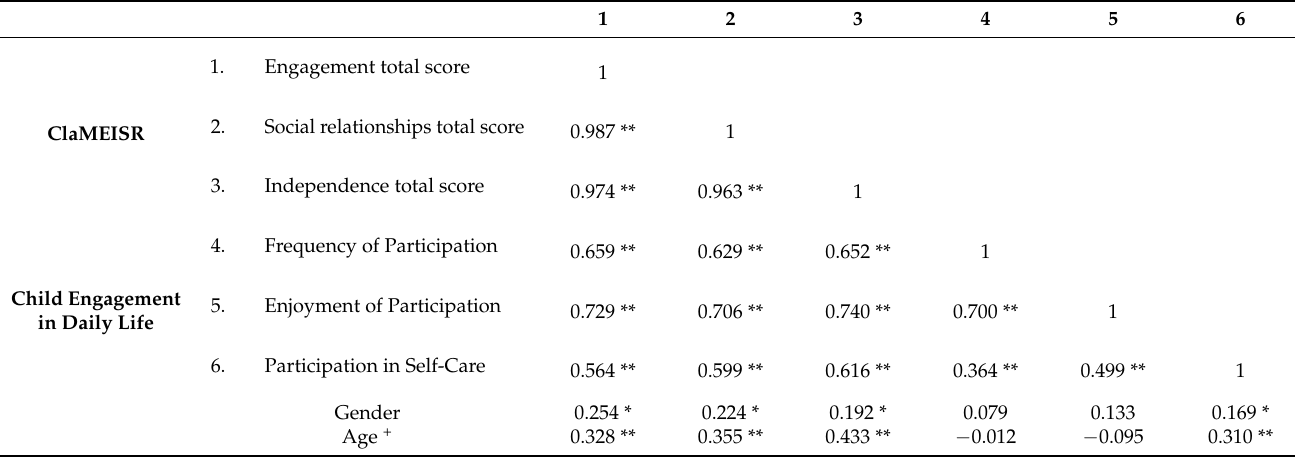
Table 3. Correlations for the Analyzed Measures.